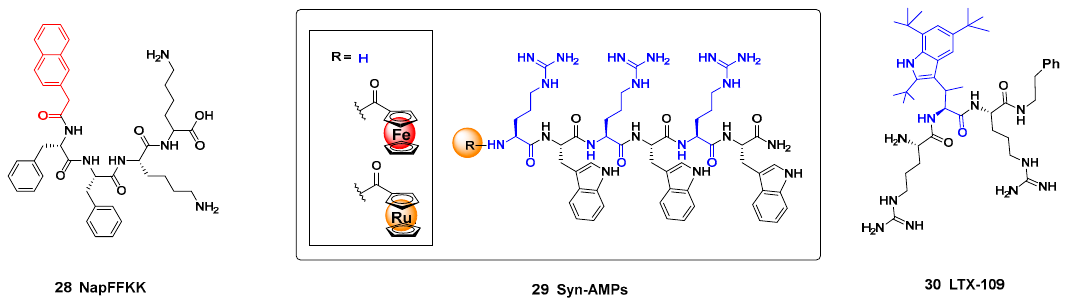
Figure 3. Structures of AMP analogues: ( Left ) the NApFFKK peptide; ( Center ) Synthetic AMPs with ferrocene or rutacene groups; ( Right ) Unnatural tryptophan units in a ferritin-inspired peptide, LTX-109.